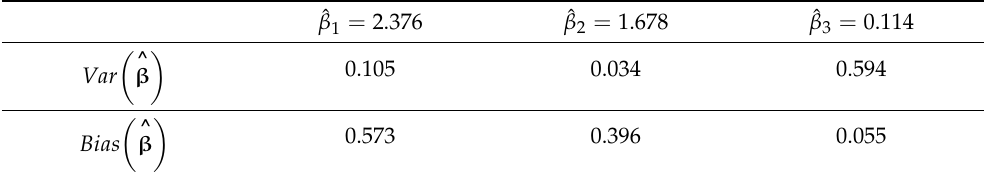
Table 4. Bias and variances of regression coefficients obtained from